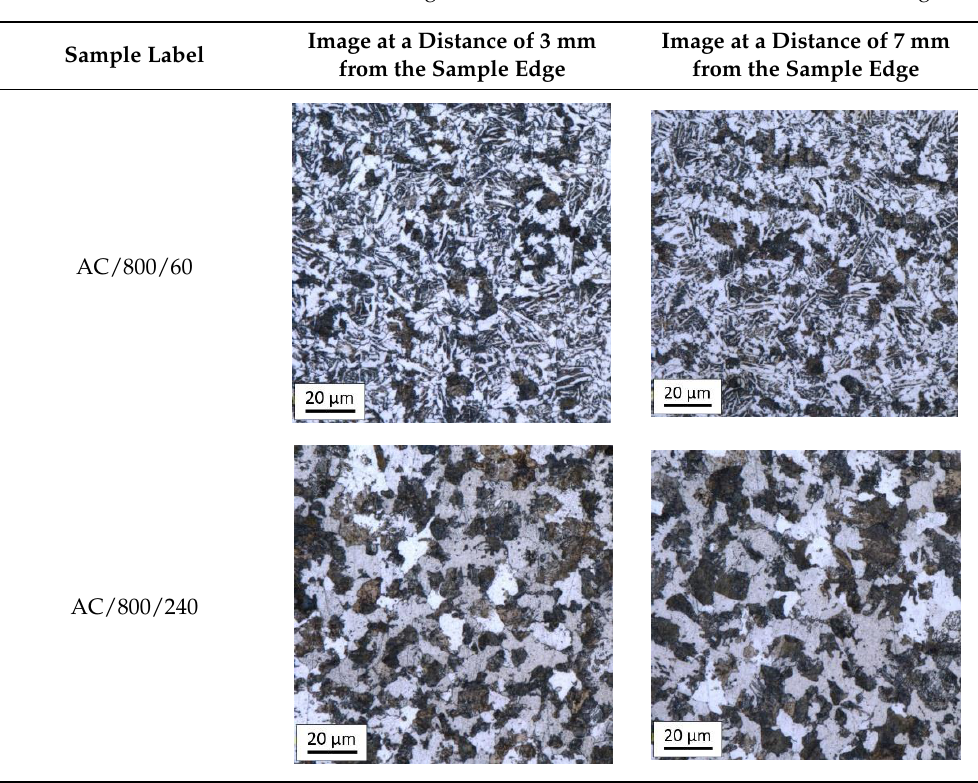
Table 6. Microstructure of steel after heating at 800 °C for 60 min and 240 min with air-cooling.